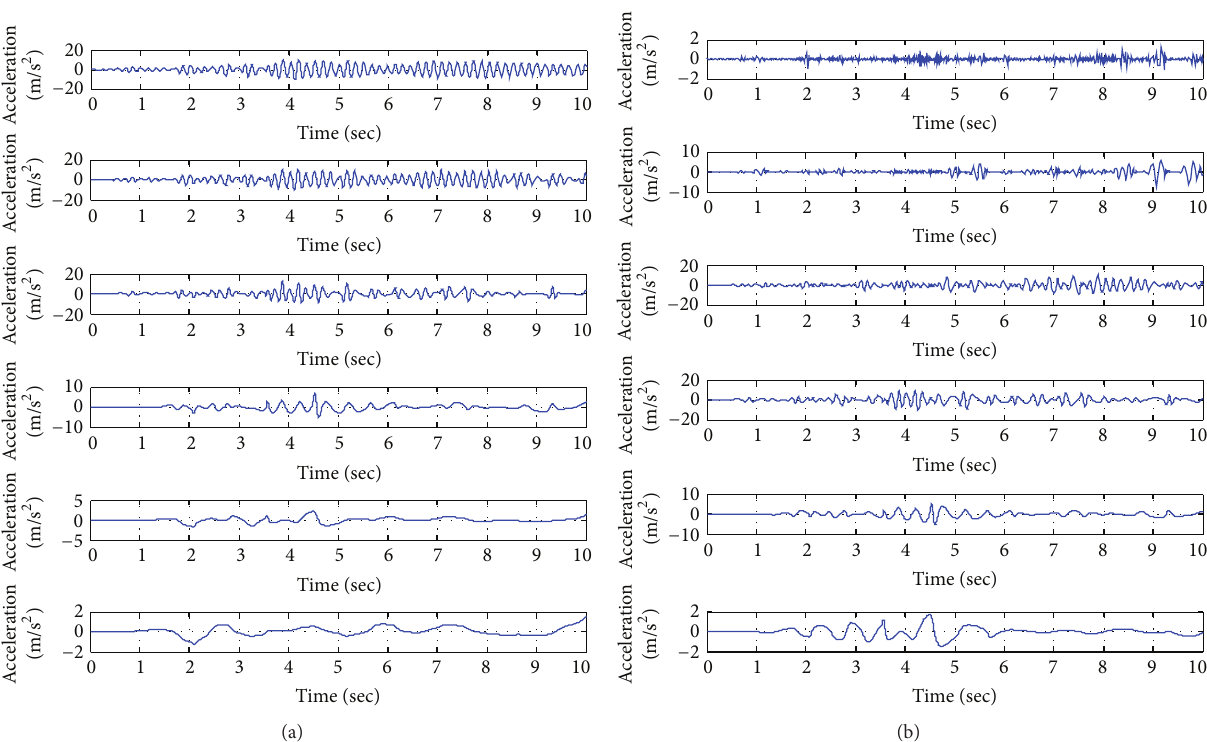
Figure 7: The regular (a) approximate and (b) detail decomposition DWT of F3